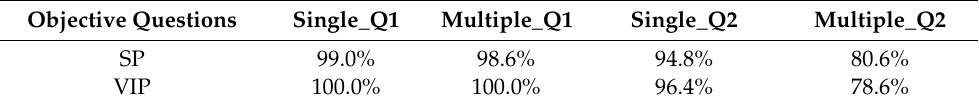
Table 6. The correct rate of objective questions in different conditions of the control group. SP indicates Sighted People; VIP indicates Visually Impaired People. Single and Multiple indicate the number of objects. Q1 and Q2 indicate the index of questions for perceiving the number and the size of